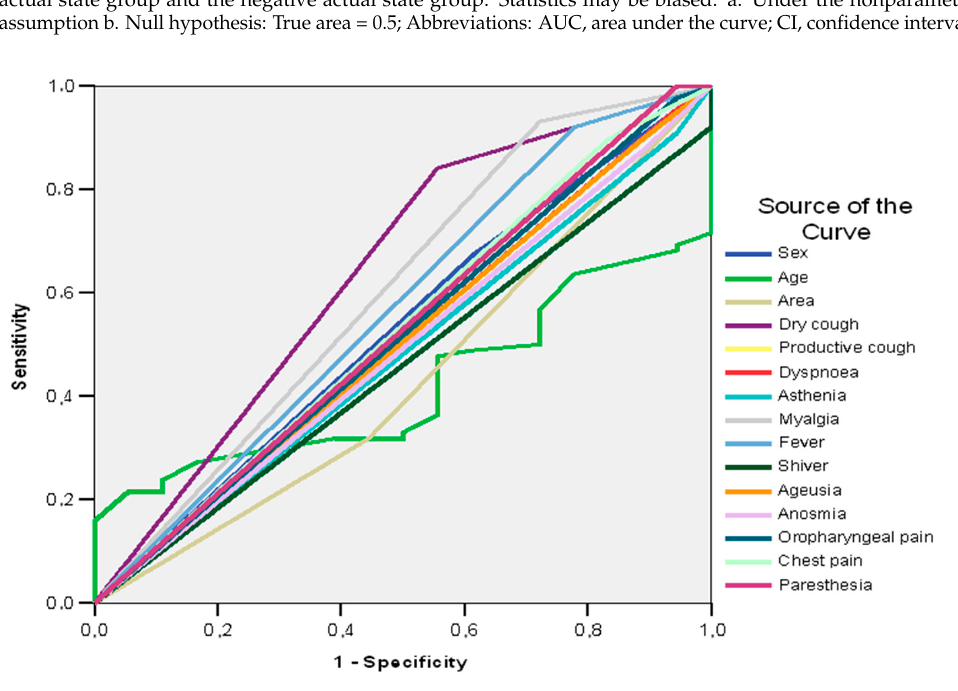
Table 4. Risk factors in SARS-CoV-2 patients with pneumonia according to personal pathological history.